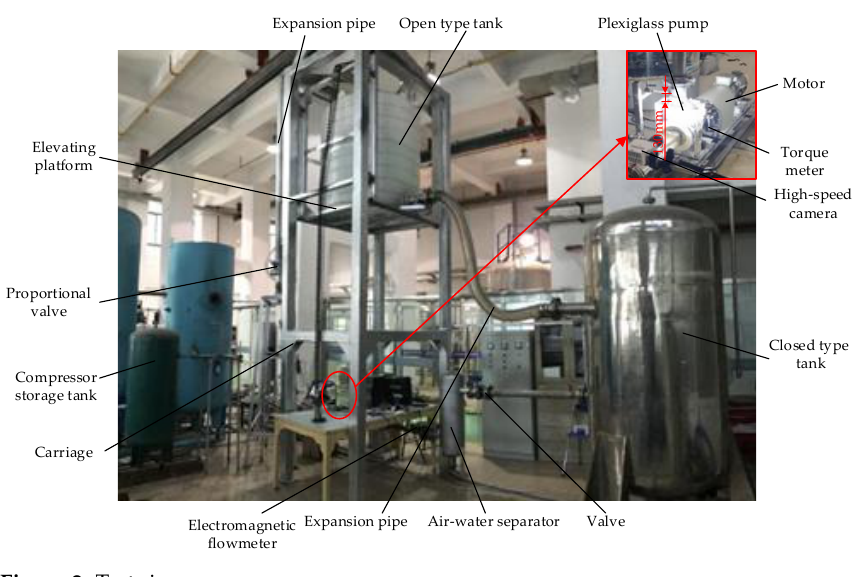
Figure 2. Test rig.